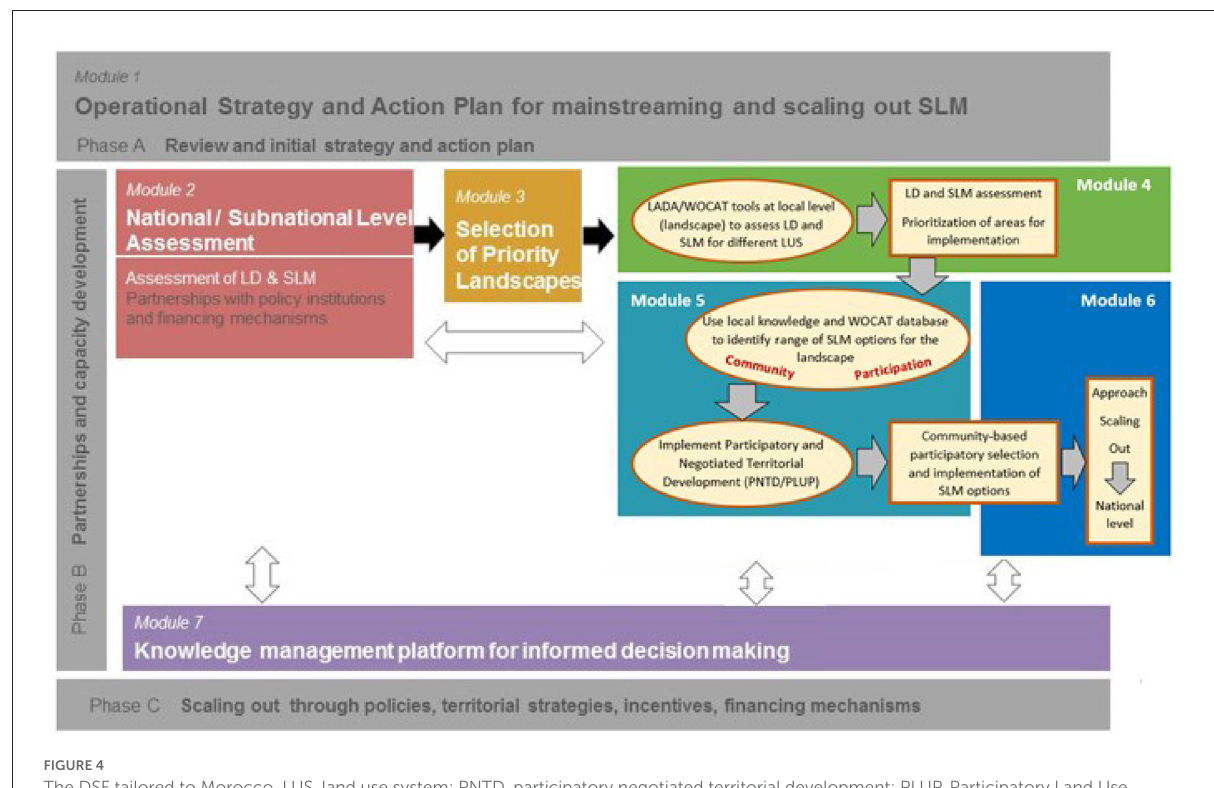
FIGURE4 The DSF tailored to Morocco. LUS, land use system; PNTD, participatory negotiated territorial development; PLUP, Participatory Land Use Planning.